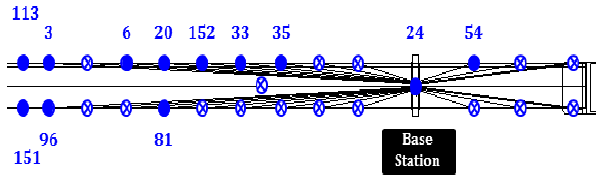
Figure 11. Sensor topology used for WSS networks reliability assessment.